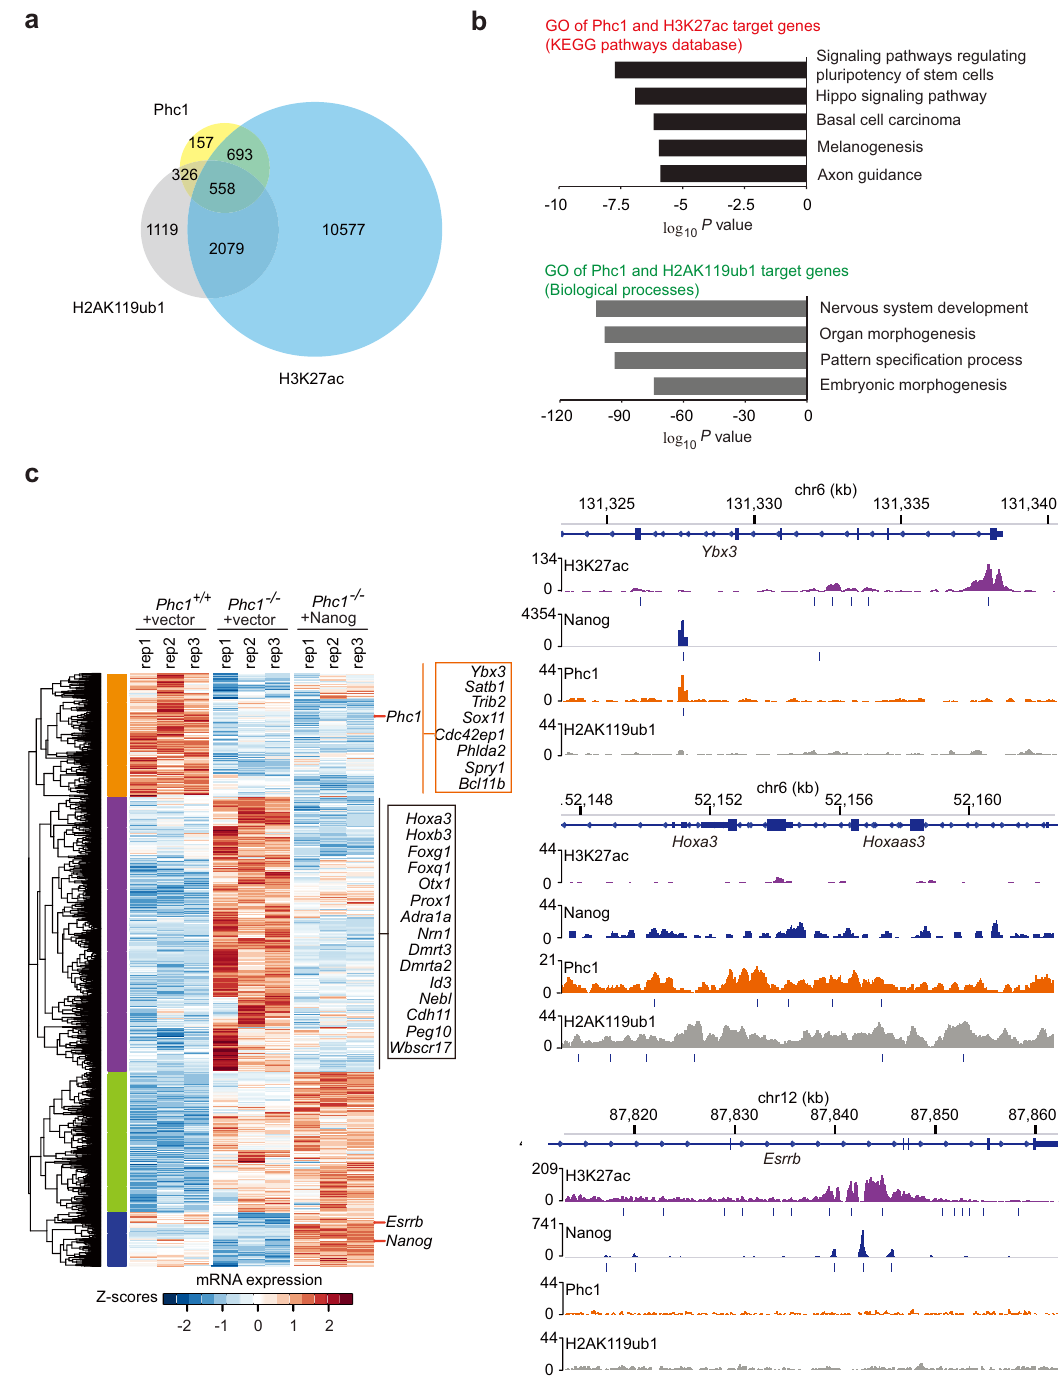
Fig. 4 Phc1 maintains pluripotency of mESCs in both PRC1-dependent and PRC1-independent regulation of Nanog. a Venn diagram analysis of genes bound by Phc1, H2AK119ub1, and H3K27ac in mESCs 22,37 . b GO analysis of signaling pathways of Phc1 and H3K27ac target genes and biological functions of genes co-occupied by Phc1 and H2AK119ub1. p values are plotted in – log 10 . c The Phc1 + / + + vector, Phc1 − / − + vector, and Phc1 − / − + Nanog mESCs were pro fi led in triplicate for RNA-seq experiments. Genes that were signi fi cantly up- or down-regulated in Phc1 − / − + vector compared with the Phc1 + / + + vector cells were clustered across all samples and were shown as heatmaps. Each row represents one gene and each column represents one sample. The Phc1-activated genes that were not changed by Nanog overexpression were shown as orange cluster and that were induced by Nanog were classi fi ed as blue cluster. Genes that were repressed by both Phc1 and Nanog were de fi ned as purple cluster. The Phc1-repressed genes but not repressed by Nanog were shown as green cluster. The IGV image showing H3K27ac, Nanog, Phc1, and H2AK119ub1 ChIP-seq binding pro fi les of representative genes from orange and purple cluster genes 8,22,37 . Source data are provided as a Source Data fi